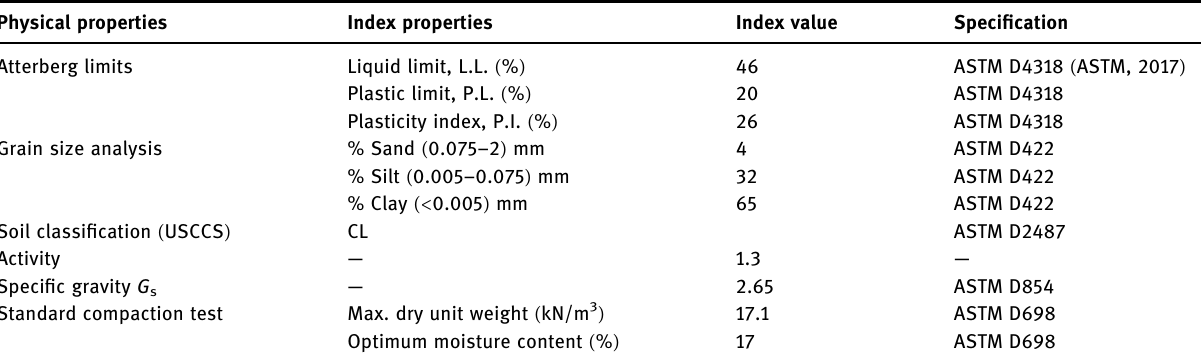
Table 1: Geotechnical properties of the soil